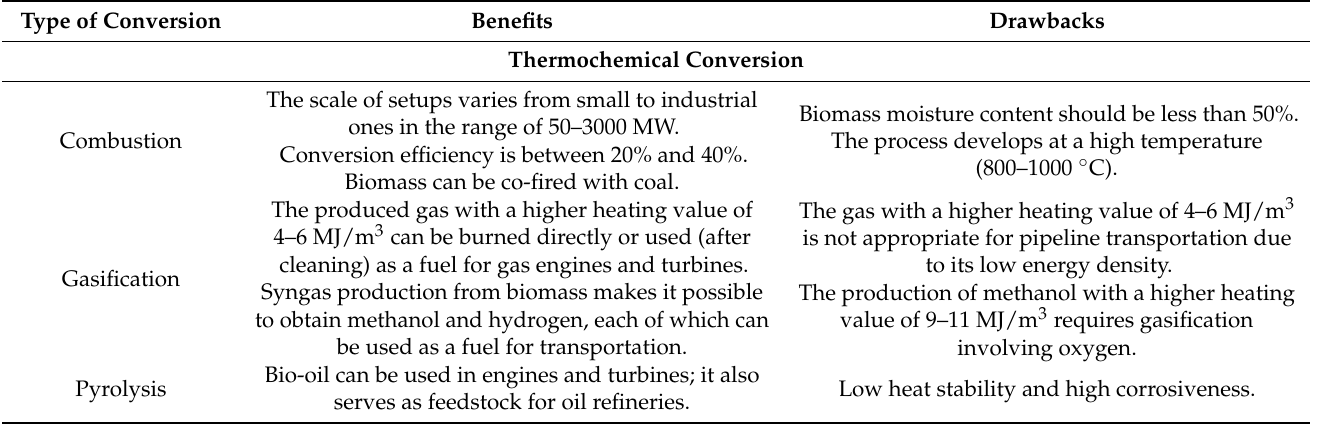
Table 1. Biomass conversion